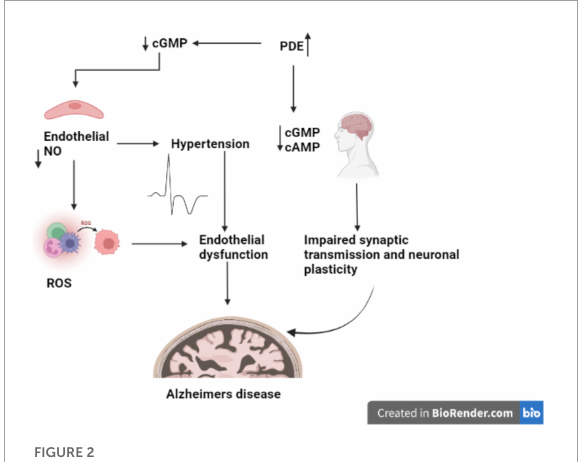
FIGURE2 Role of PDE in AD. The figure is original and generated by Bio-render